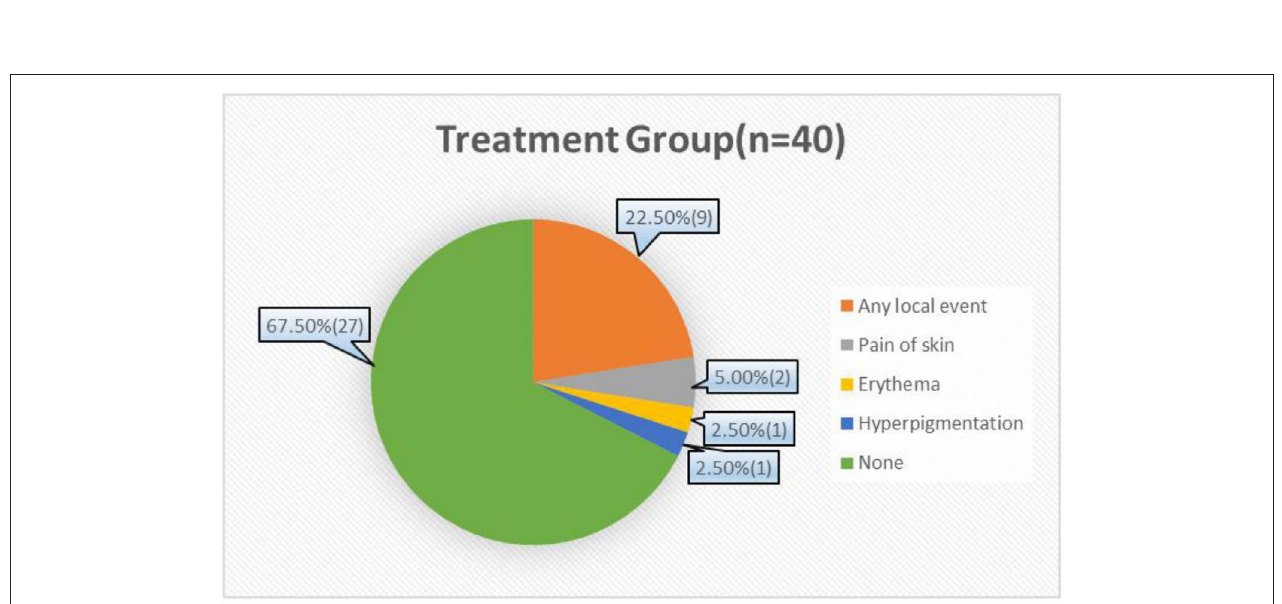
FIGURE 6 | Side effects occurred during the course of treatment in the treatment group.